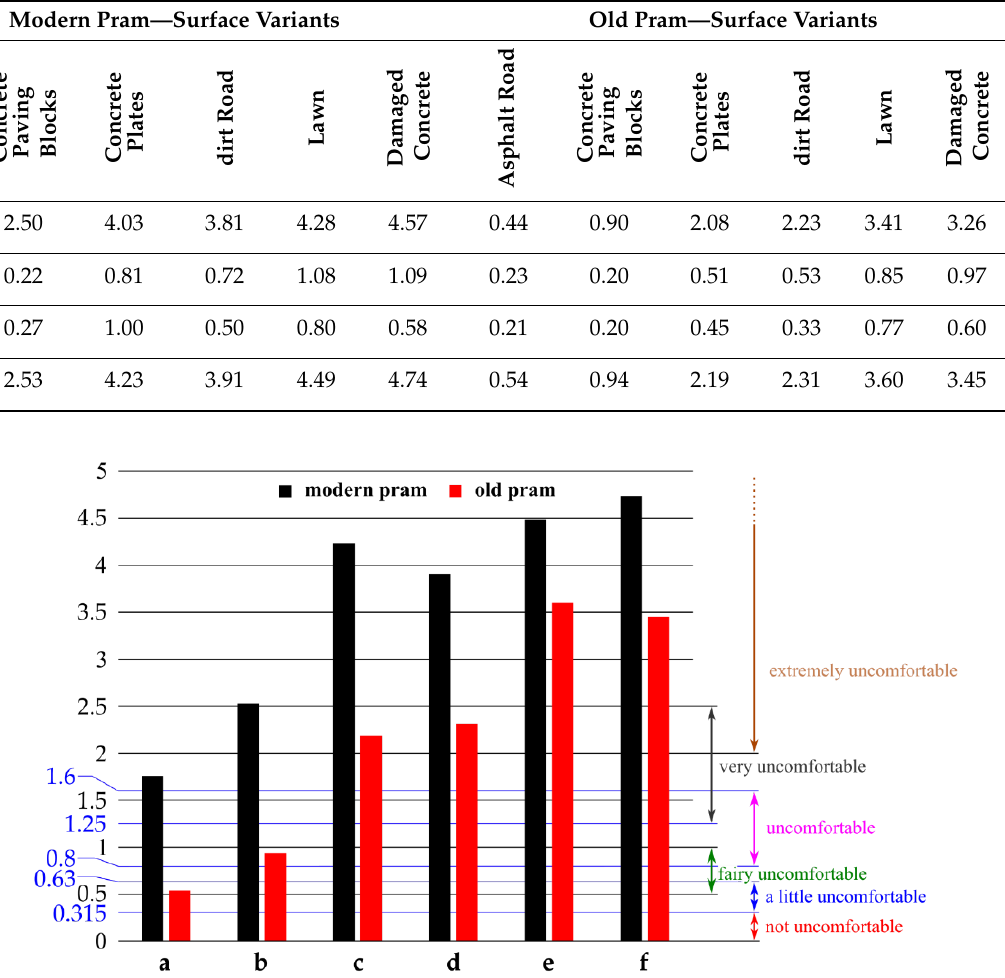
Figure 8. Comparative bar graphs of the weighted RMS acceleration values from ISO 2631-1:1997 [18]. According to the discomfort levels from ISO 2631-1:1997 [18] (Figure 8), all the vi- brations whose vibration total values ( a w ) exceed 0.315 m/s 2 are not comfortable.